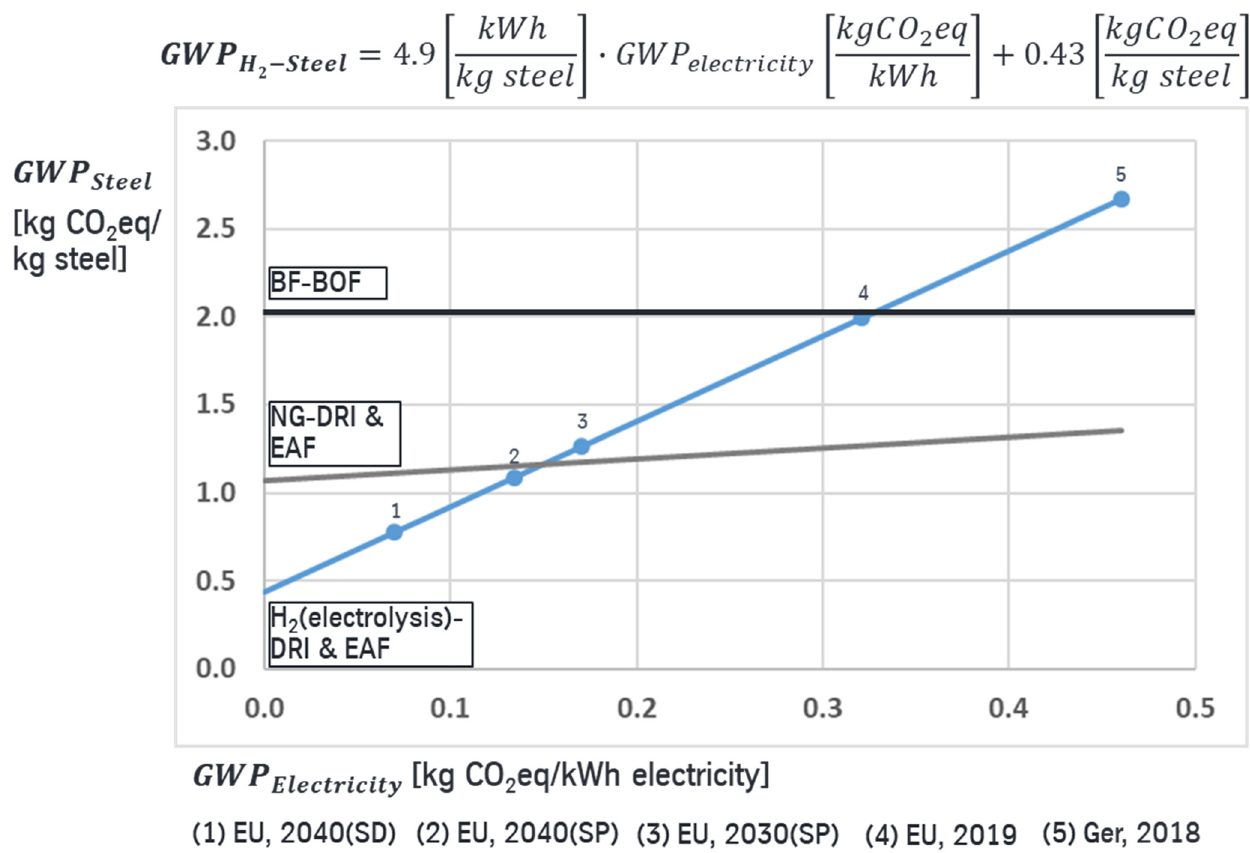
Figure 12. Global warming potential (GWP) of steel, produced using hydrogen-based direct reduction (DR) plant and EAF, in function of the GWP of the electricity mix. Electricity is used for the electrolysis process, the DR plant, and the electric arc furnace (EAF). Abbreviations: SP, stated policy scenario; SD, sustainable development; NG, natural gas.